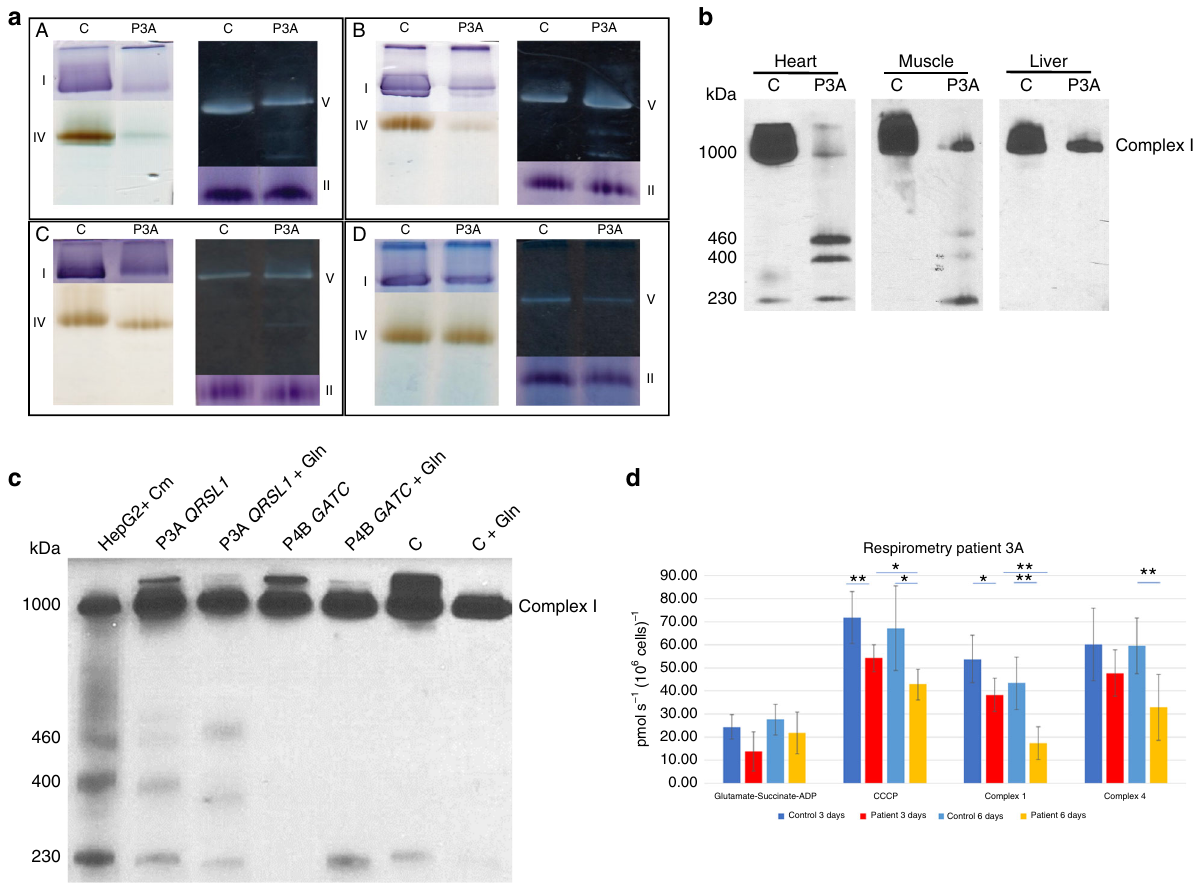
Fig. 4 Mitochondrial function studies. a Blue native polyacrylamide gel electrophoresis with in-gel activity staining of solubilized respiratory chain enzyme complexes from a mitochondrial membrane pellet of heart muscle ( A ), skeletal muscle ( B ), liver ( C ), and fi broblasts ( D ) show decreased activities of complexes I and IV (except in fi broblasts) with additional low molecular weight bands of complex V in heart, muscle and to a lesser extent liver of patient P3A. b Analysis of the assembly of complex I in heart, skeletal muscle, and liver of patient P3A. The assembly of complex I was evaluated by separation on a native gel followed by western blotting and probing with an antibody against NDUFS2, a subunit which is present from the early stages of assembly. Abnormal subcomplexes of incompletely assembled complex I are visible in heart muscle, to a lesser extent in skeletal muscle, and absent in liver. c The assembly of complex I is shown for fi broblasts cultured in the presence (2 mM) or absence of added glutamine ( + Gln) to the tissue culture media, with HepG2 cells cultured with chloramphenicol (HepG2 + CM) showing typical subassembly intermediates, in comparison to control fi broblasts. d High- resolution respirometry using a SUIT protocol of fi broblasts from patient P3A is shown following withdrawal of glutamine for 3 and 6 days. Maximum coupled respiration using substrates pyruvate, glutamate, and succinate in the presence of ADP is not different, but after uncoupling with CCCP, the patient ’ s fi broblasts ( n = 5) have signi fi cantly decreased rate compared to controls ( fi ve controls, average of triplicate analysis). Calculated complex I and complex IV rates are decreased in patient after 6 days withdrawal. Mean and standard deviation are shown, and differences evaluated by two-sided t -test. * p <0.05; ** p